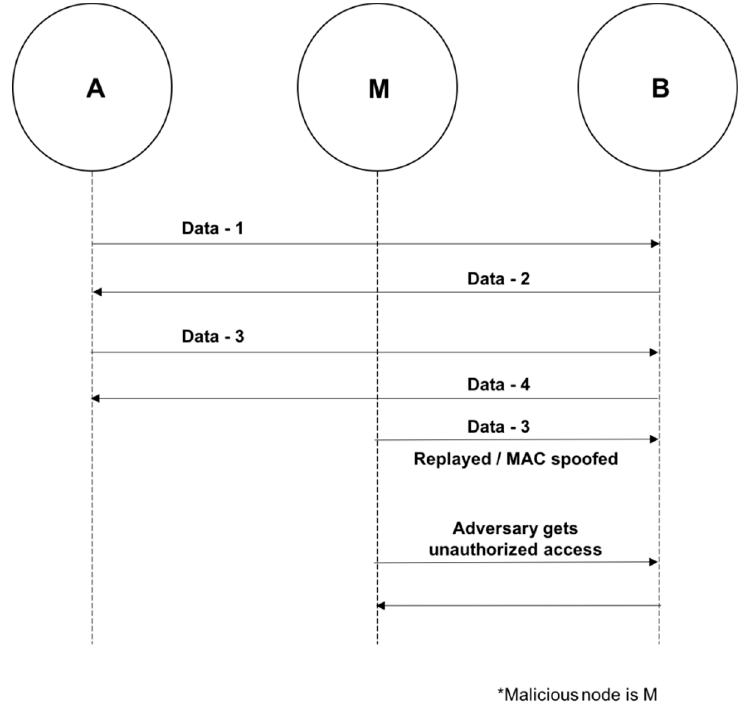
Figure 7. MAC Spoofing Attack.